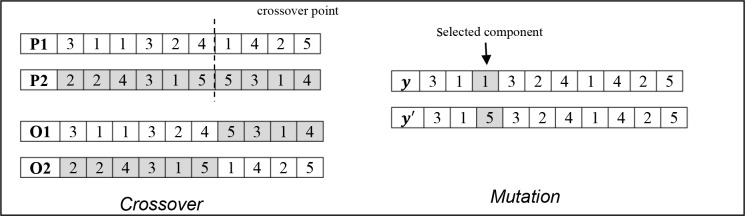
Genetic operators.